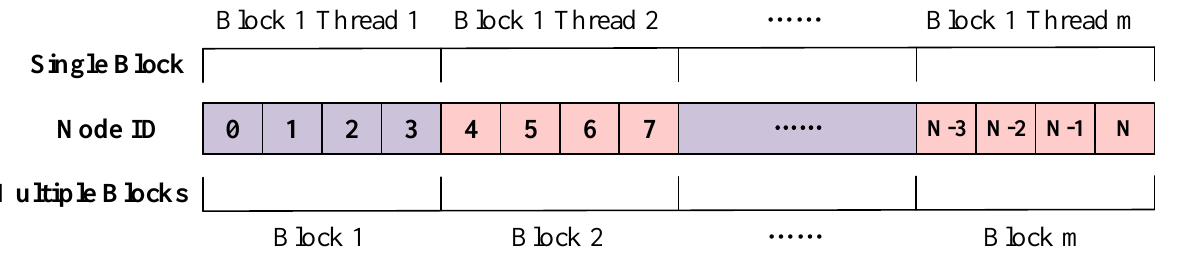
Figure 7. Illustration of single block and multiple blocks iteration.